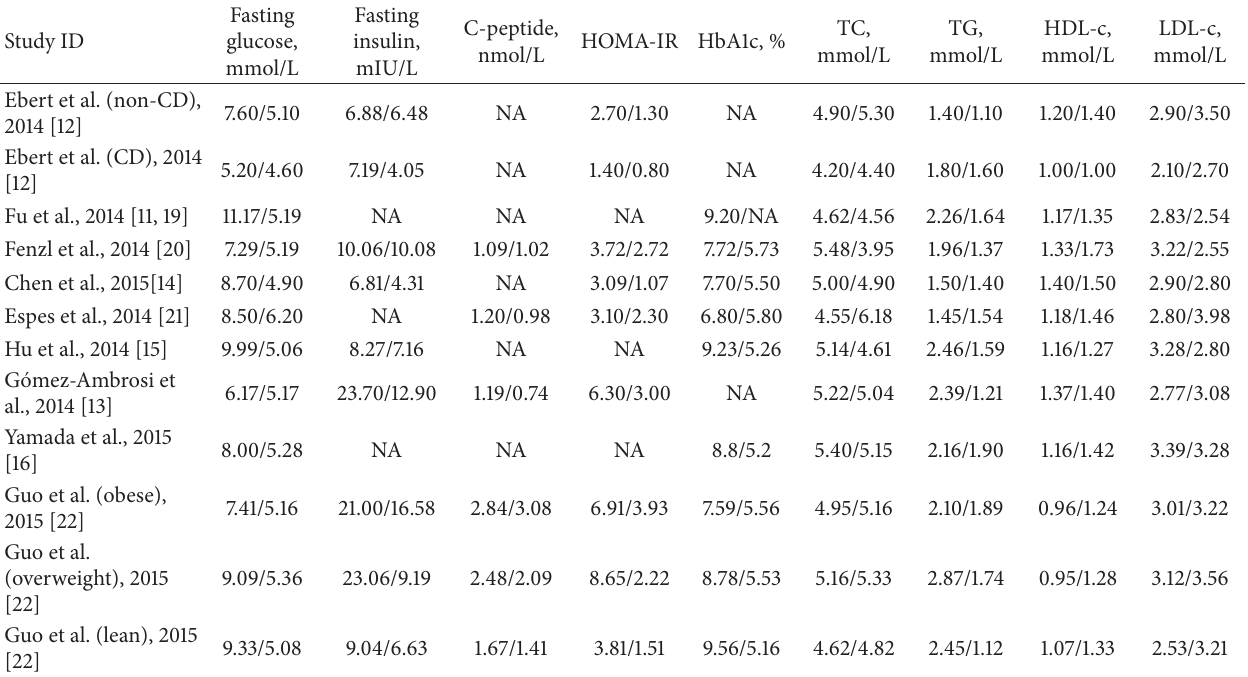
Table 2: Baseline characteristics of the enrolled